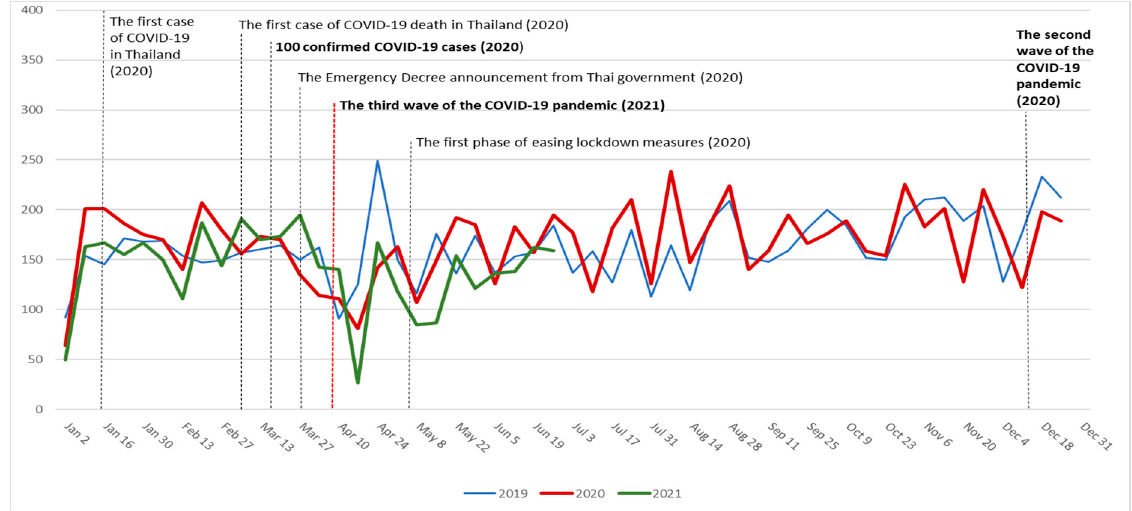
Figure 1. The number of dermatology clinic visits per week from 1 January 2019 to 30 June 2021. The dates of the major events are represented by the vertical lines. The blue line represents 2019, the red line represents 2020 and the green line represents 2021.